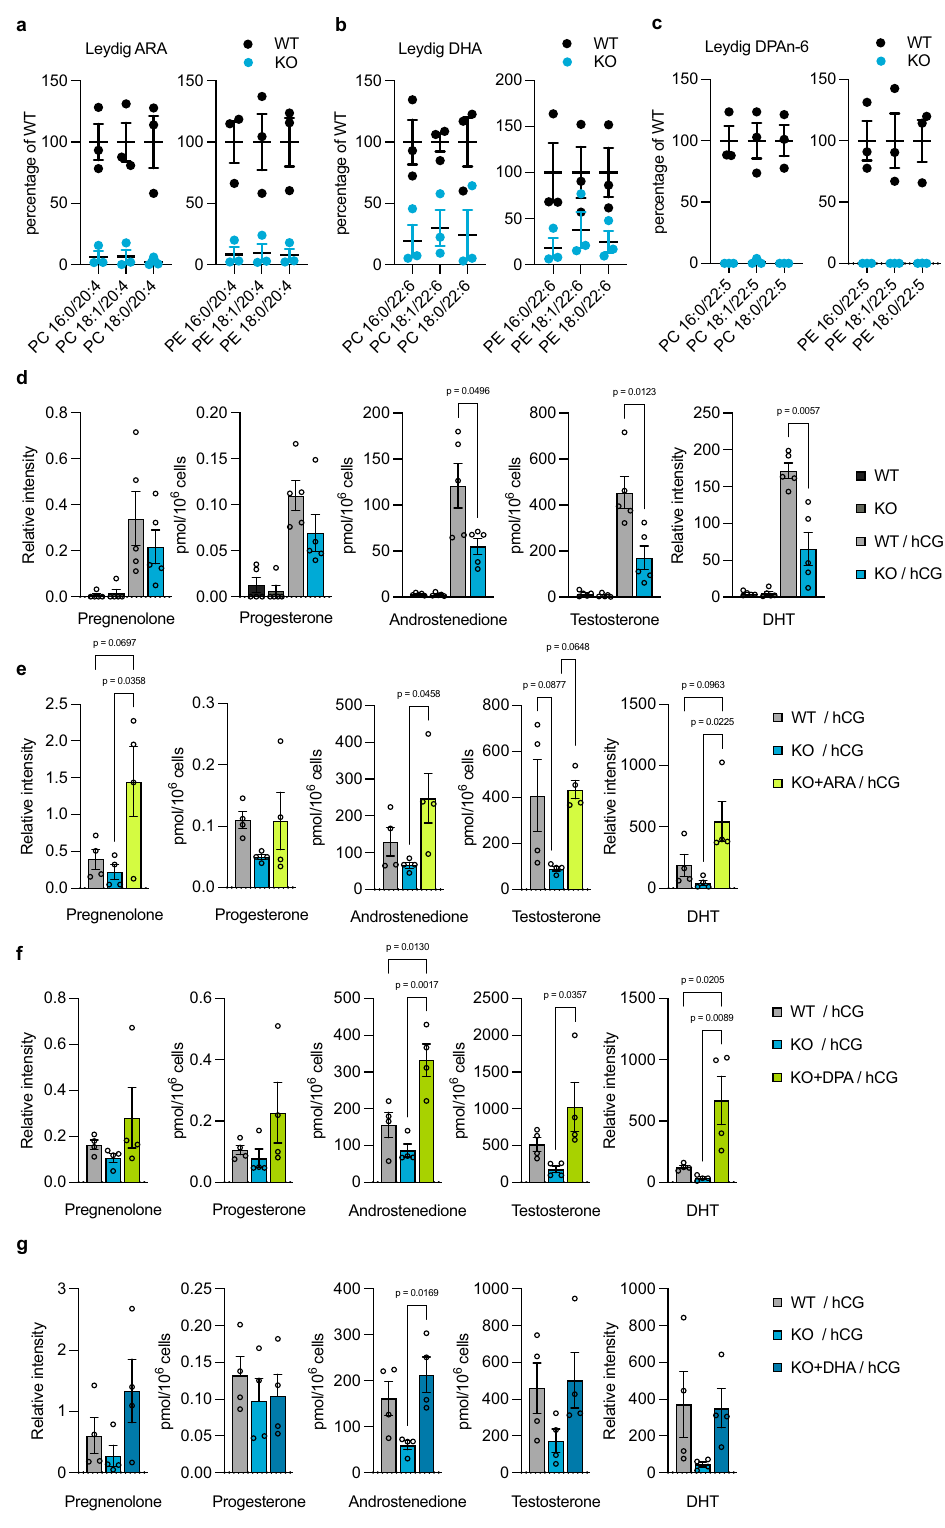
Fig. 4 Omega-6 HUFAs are required for steroid hormone production in Leydig cells. a – c Quanti fi cation of HUFA species in Leydig cells from FADS2 + / + (WT) and FADS2 − / − (KO) mice. n = 3 for each group. The detailed lipidomics data are shown in Supplementary Fig. 5. d Reduced steroid hormone production in Leydig cells from FADS2 − / − mice. Steroid hormones were extracted from the supernatant. n = 4 for each group. Signi fi cance is based on unpaired two-tailed t -test with Welch ’ s correction. e – g Steroid hormone production in Leydig cells from FADS2 − / − mice supplemented with ARA ( e ), DPAn-6 ( f ), or DHA ( g ). n = 4 for each group. Signi fi cance is based on Tukey ’ s multiple comparisons test. Data shown are the mean ± SEM. Steroid hormone levels in the cell pellets were shown in Supplementary Fig. 5f – h. DHT dihydrotestosterone, hCG human chorionic gonadotropin, ARA arachidonic acid, DHA docosahexaenoic acid, DPA n-6 docosapentaenoic